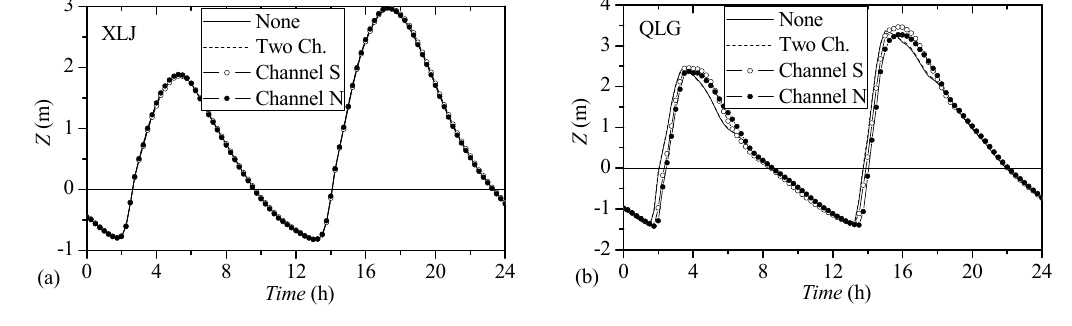
Table 5. Variations of cross-sectional water levels ( Z ) in Yangtze Estuary after GYS Regulation (cm).